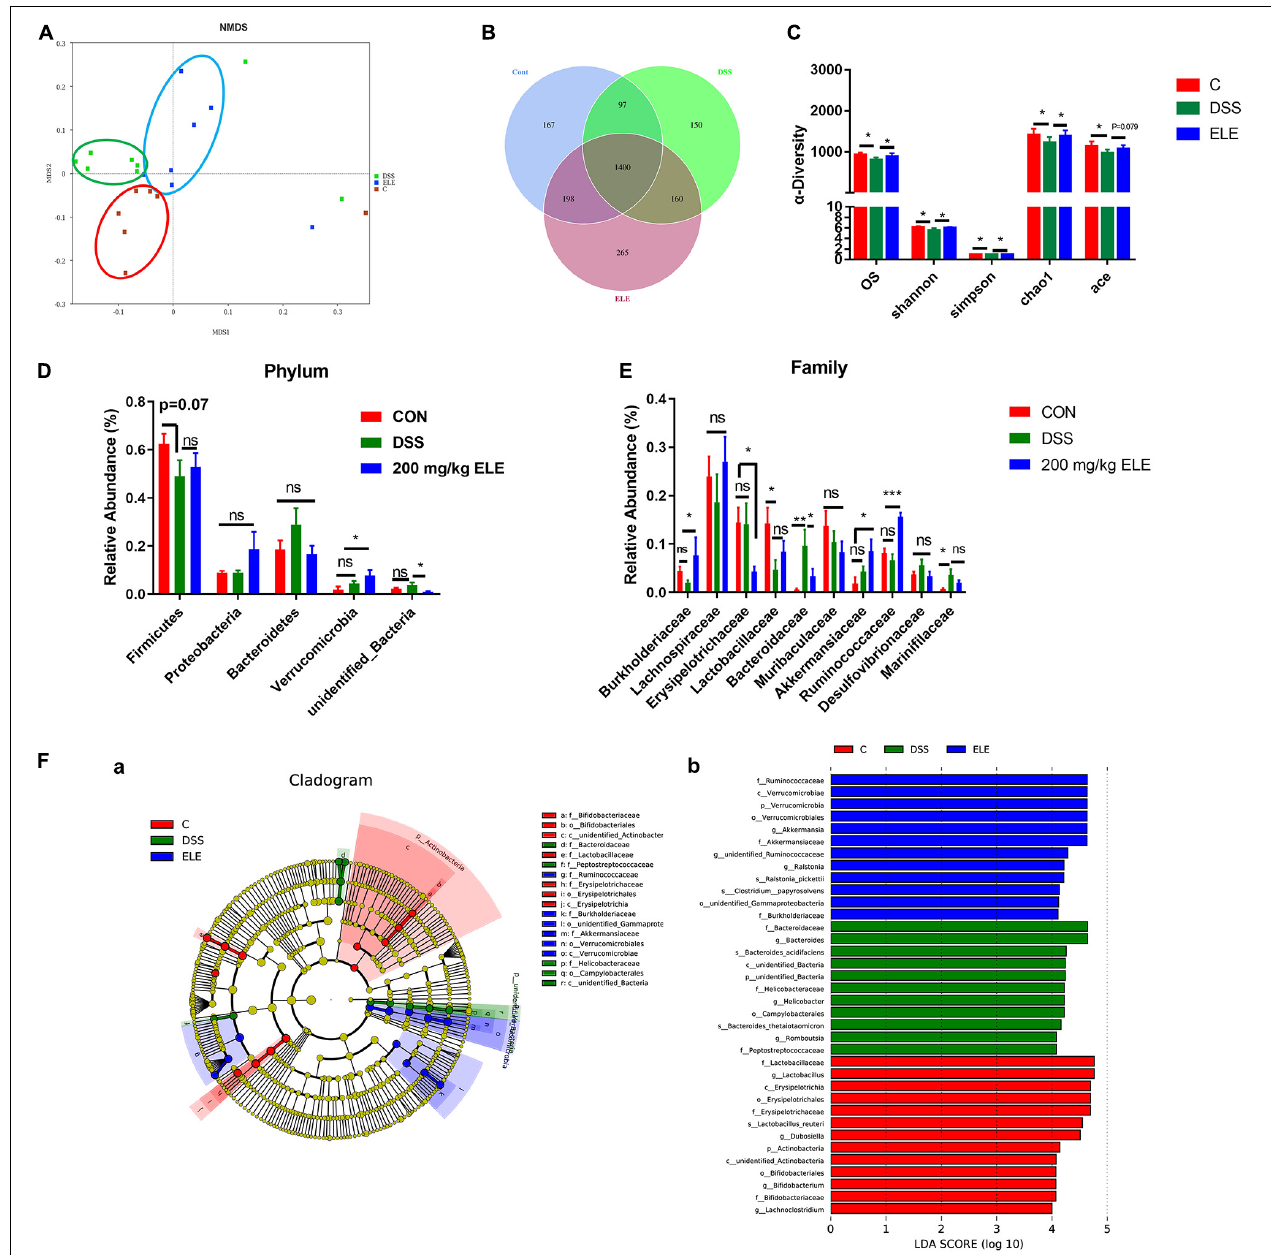
FIGURE 3 | Effects of ELE on the gut microbiota in mice. (A) The NMDS plot of gut microbiota. (B) The Venn plot based on OTUs of gut microbiota. (C) The OS, diversity, and abundance index of gut microbiota. (D) Oral administration of ELE regulates the microbiota of IBD mice in phylum level. (E) Oral administration of ELE regulates the microbiota of IBD mice in family level. (F) Identification of characteristic microbiota in cecal contents of mice with different treatments by LEfSe analysis, (a) LefSe taxonomic cladogram and (b) LDA score. n = 7–8 mice/group. Differences in data in mouse subjects were assessed by one-way ANOVA. * p < 0.05; ** p < 0.01; *** p < 0.001. NMDS, non-metric multidimensional scaling. OTU, operational taxonomic unit; LEfse, LDA effect size; LDA, linear discriminant